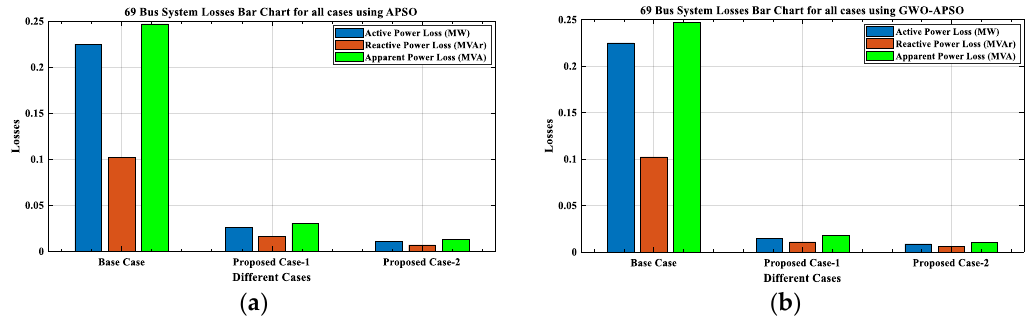
Figure 24. Cumulative bar representation of P Loss , Q Loss , and S Loss for all cases of 69-bus RDN; ( a ) APSO, ( b ) GWO-PSO.